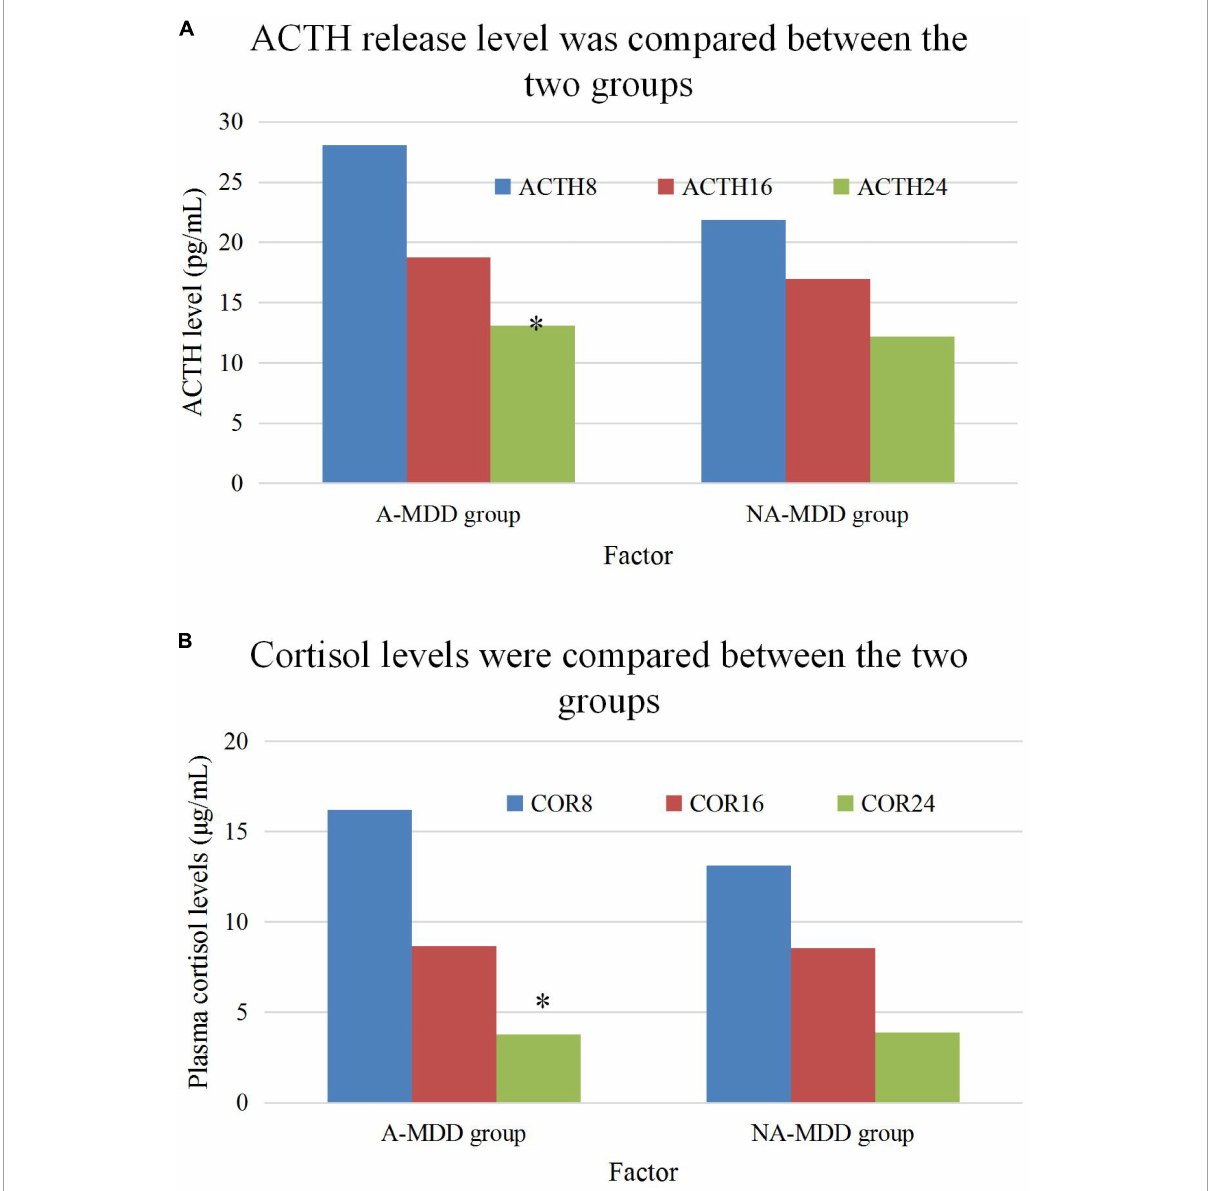
FIGURE6 Comparison of ACTH and cortisol plasma levels. (A) Is the comparison of ACTH level and (B) is the comparison of cortisol plasma level. ∗ Meant P < 0.05 compared with the NA-MDD